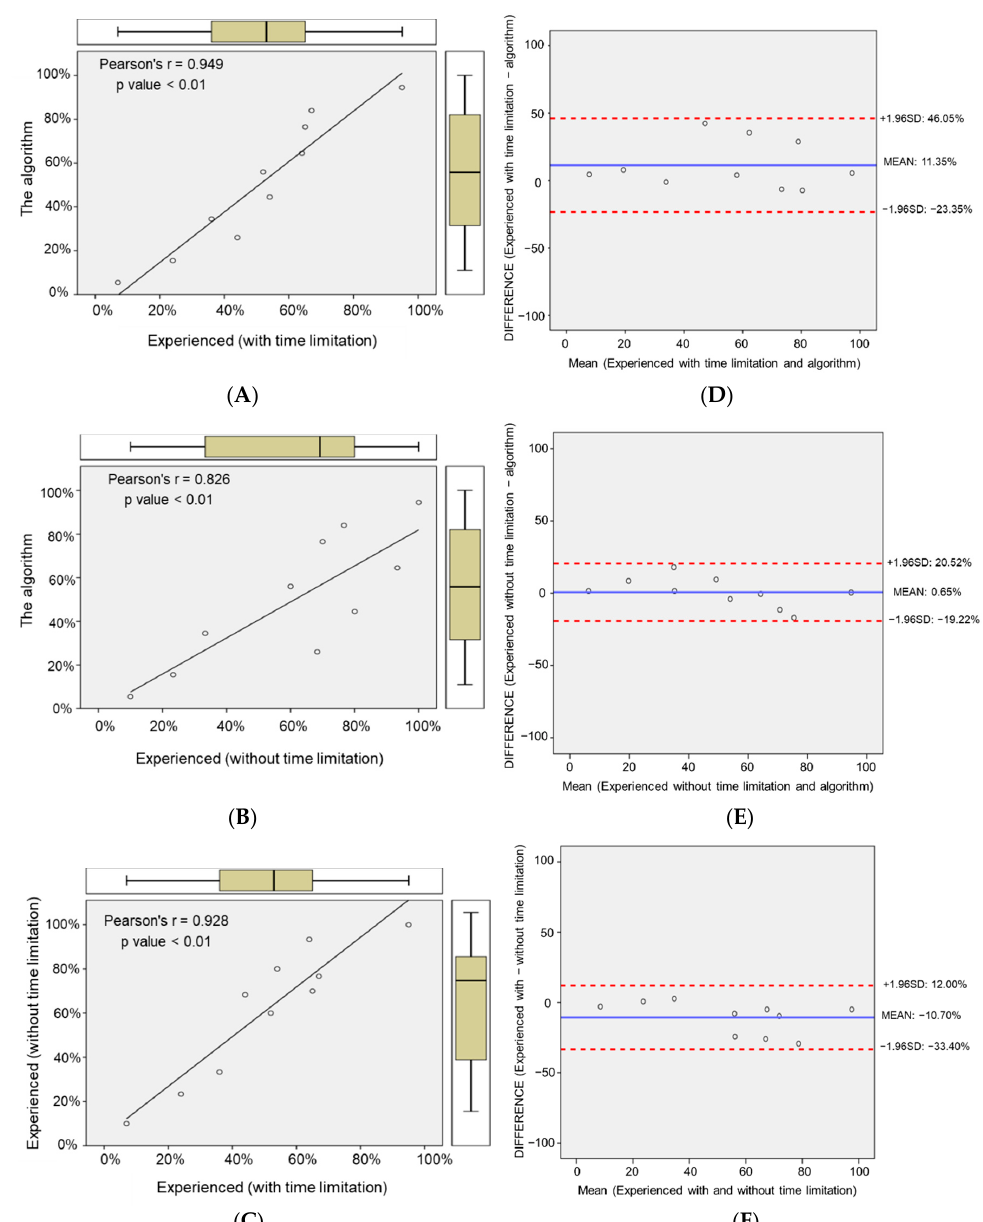
Figure 7. The correlation of the algorithm-determined cell confluence and that determined by ( A ) experienced researchers with time limitation (examined the images in 1 min) and ( B ) experienced researchers without time limitation. ( C ) The correlation of the cell confluence levels was measured by experienced researchers with or without time limitation. The Bland–Altman analysis determined the 95% limit of agreement between ( D ) the novices and experienced researchers with time limitation (examined the images in 1 min); ( E ) novices and experienced researchers without time limitation; and ( F ) novices and the algorithm.